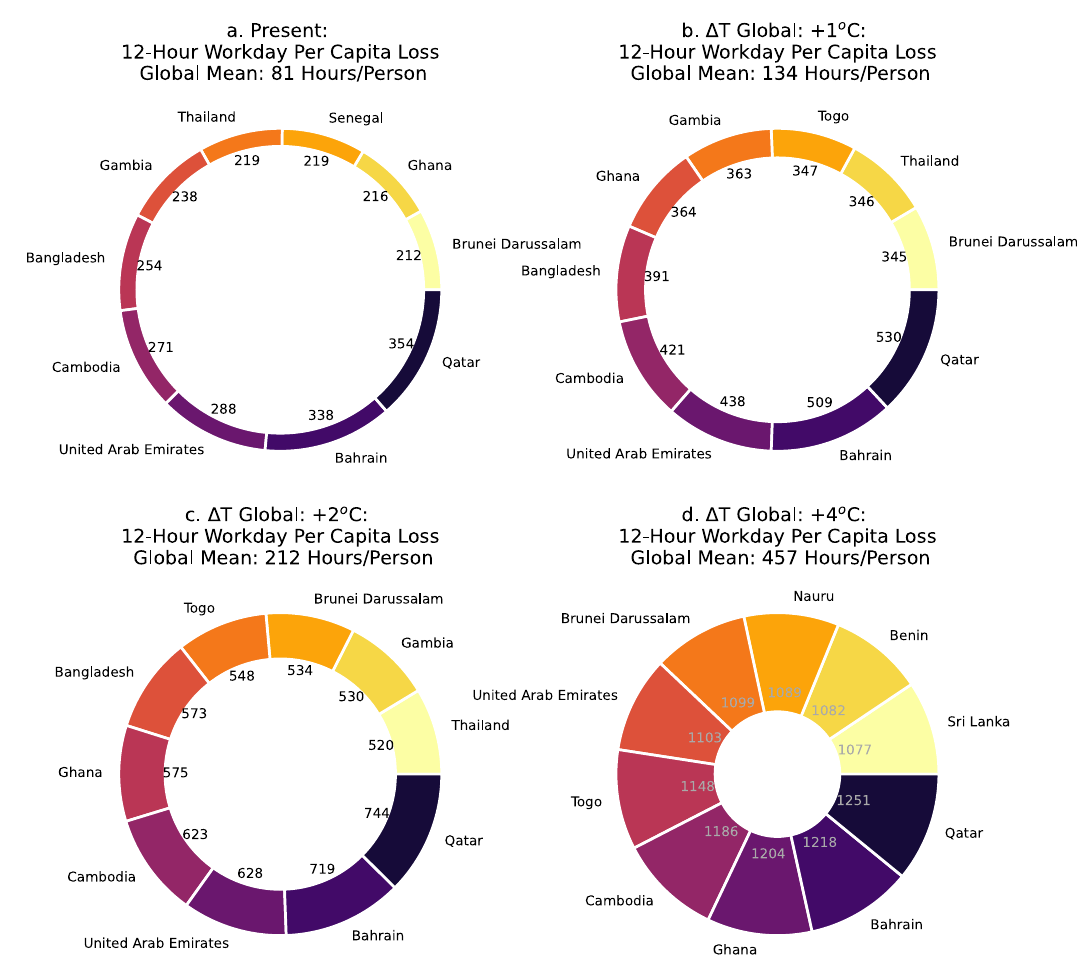
Fig. 5 Countries with the highest per-capita labor losses from heat exposure. The ten countries with the most per-capita labor losses in the 12-h workday in heavy labor due to heat exposure in the present ( a 2001-2020 mean), and with + 1 °C, + 2 °C, and + 4 °C of additional global warming ( b – d , Global Δ T ). The global mean of labor lost (average of 163 countries with available data; Supplementary Table 1) is shown above each plot, the numbers around the center of the circle show individual losses per country, and the thickness of the circle increases as the global mean of labor lost increases with warming. All units are in